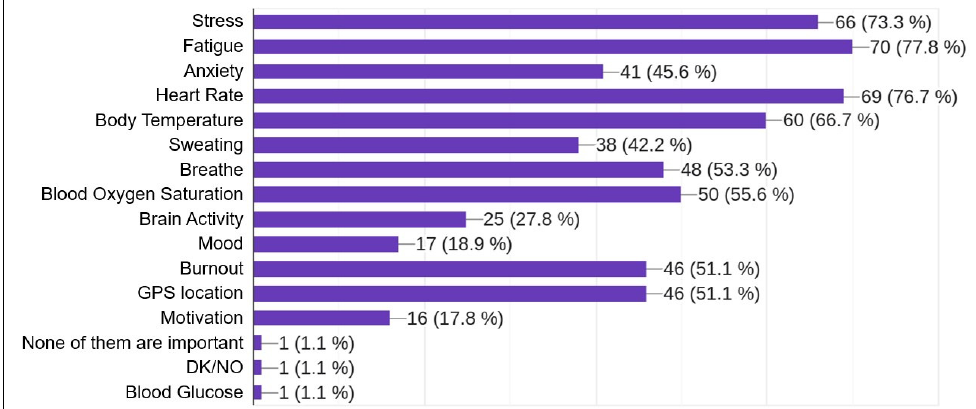
Figure 13. Answers to question: Items to be investigated in bio-signal monitoring.